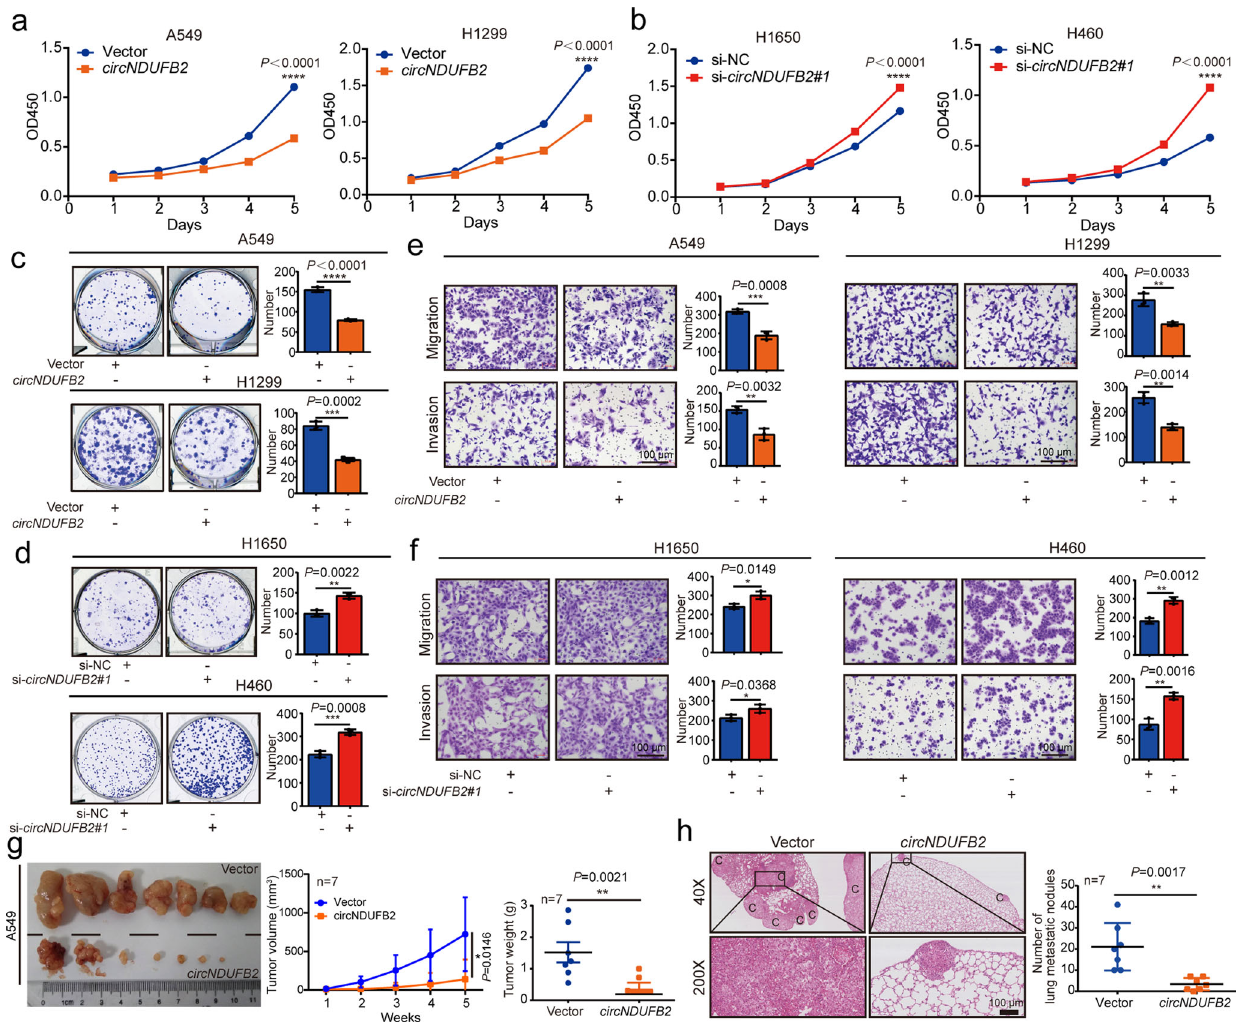
Fig. 2 circNDUFB2 inhibits proliferation and metastasis of NSCLC cells in vitro and in vivo. a , b Cell proliferation assays for NSCLC cells with circNDUFB2 overexpression or knockdown. n = 5 biologically independent samples. c , d Colony formation assays for NSCLC cells with circNDUFB2 overexpression or knockdown. n = 3 biologically independent samples. e , f Migration and invasion assays for NSCLC cells with circNDUFB2 overexpression or knockdown. n = 3 biologically independent samples. Scale bar = 100 μ m. g The volume and weight of subcutaneous xenograft tumors ( n = 7 mice per group). h Representative pictures of the lung metastases in nude mice by H&E staining ( n = 7 mice per group). C cancer site. Scale bar = 100 μ m. Data are presented as mean ± s.d. P values are calculated by unpaired two-sided t -test in a , b and c – h